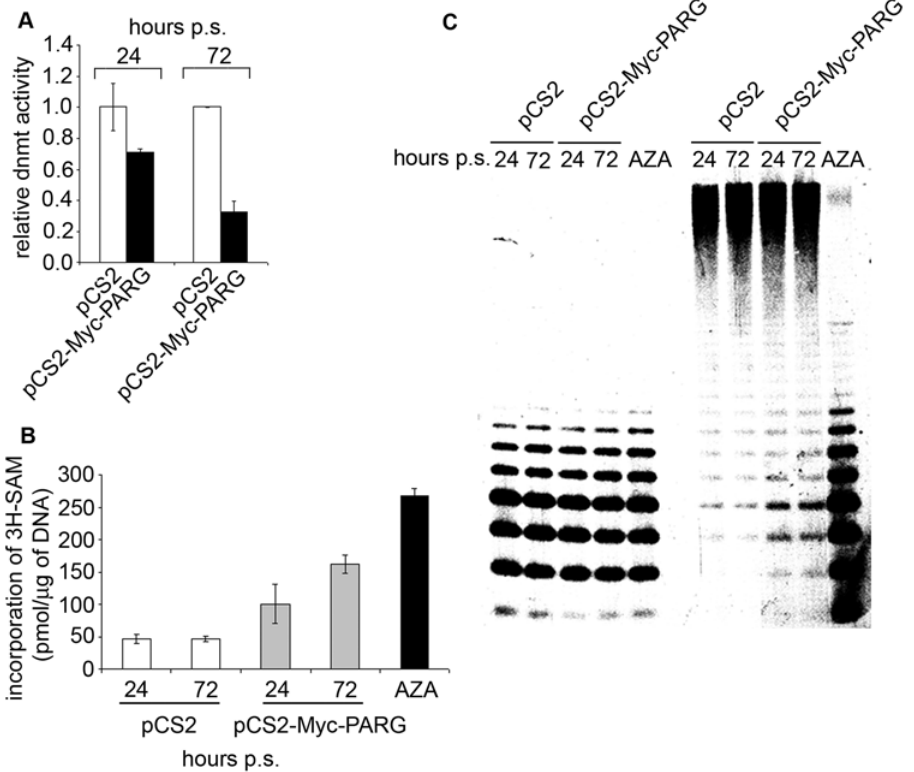
Figure 6. Dnmt1 down-regulation dependent on PARG over-expression leads to a widespread genome hypomethylation. A, Endogenous DNA methyltransferase activity (dnmt) of nuclear extract from cultures at 24 and 72 hours of puromycin selection transfected with either pCS2 (white bar) or pCS2-Myc-PARG (black bar) vectors. The DNA methyltransferase activity of pCS2 samples was considered as 1.0. B, Methyl- accepting ability assay was carried out on genomic DNA purified from cells transfected with either pCS2 (white bars) or pCS2-Myc-PARG (black bars) vectors at 24 and 72 hours of puromycin selection. Results are displayed as number of picomoles of labelled S-Adenosyl methionine incorporated per microgram of DNA. DNA obtained from cells treated with 5-AZA was used as positive control for genome hypomethylation (black bar). Data reported in A and B are mean 6 S.E. of three experiments, each performed in triplicate. C, Analysis of Southern blot against minor satellite DNA repeats performed on genomic DNA purified from cells transfected with either pCS2 or pCS2-Myc-PARG vectors at 24 and 72 hours of puromycin